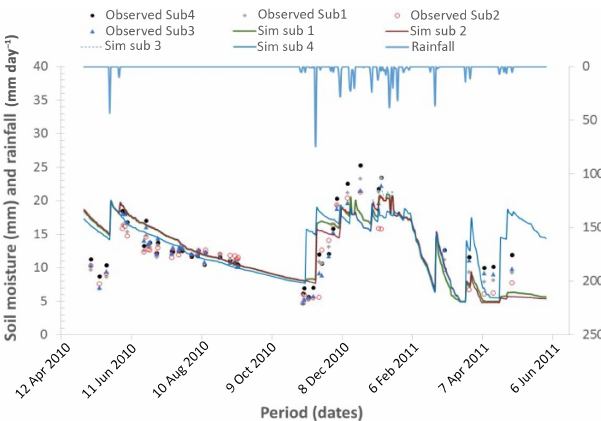
Figure 6. Model verification farm